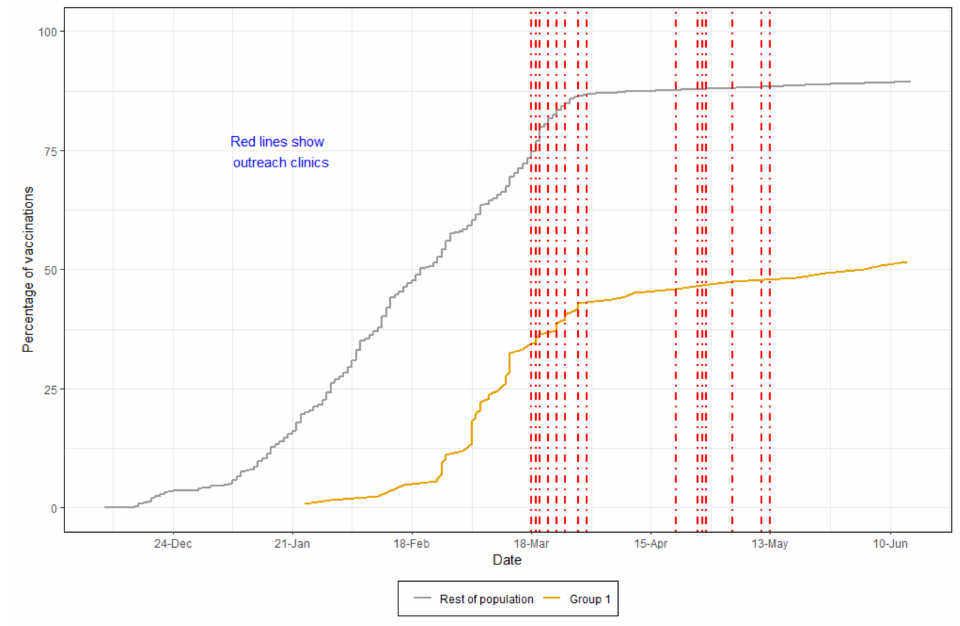
Figure 1. Vaccination rates (first vaccines) for homeless people compared to the BNSSG population. The red dotted lines represent some of the outreach